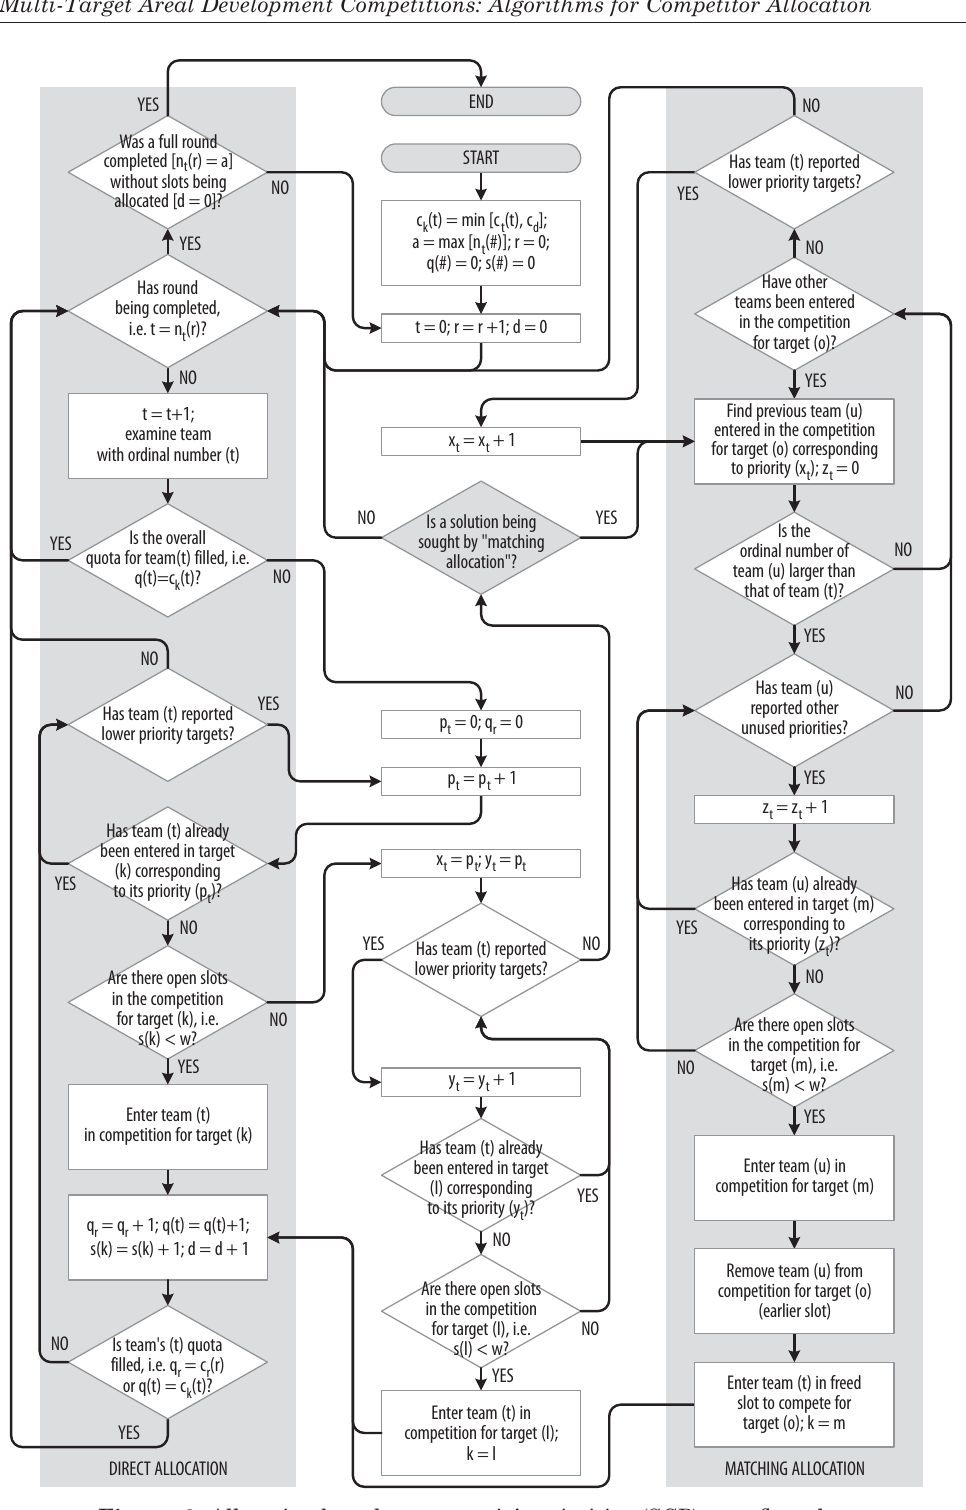
Figure 3. Allocation based on consortia’s priorities (SCP) as a fl ow